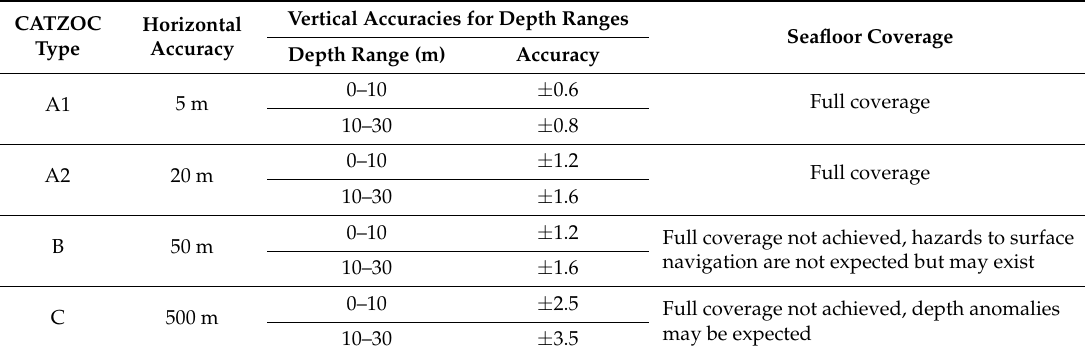
Table 6. IHO CATZOC specifications